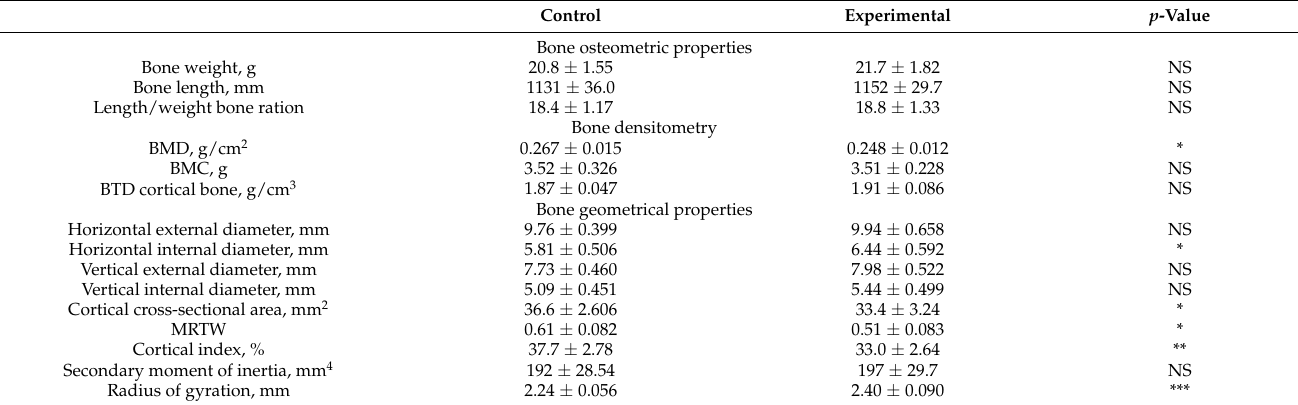
Table 1. The effect of C. perfringens infection on osteometry, densitometry, and geometrical properties of the tibia in examined animals at the age of 42 days.